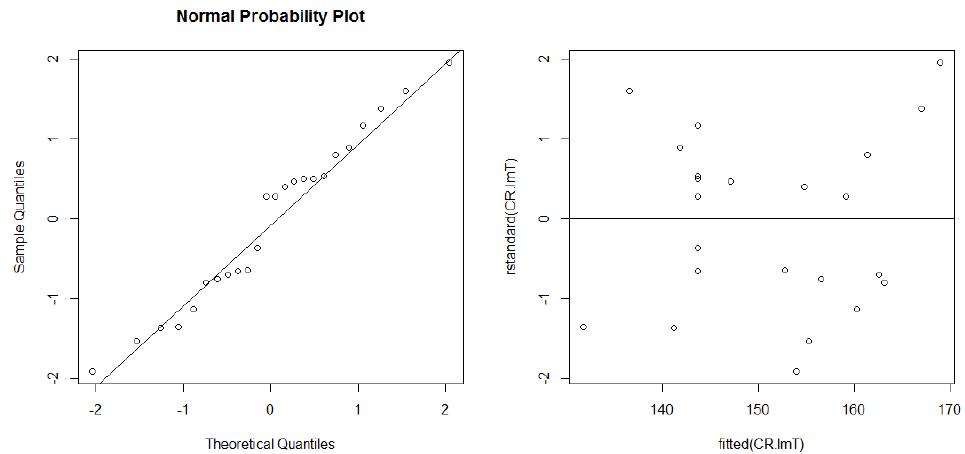
Figure 9. Normal probability plot of residuals, and plot of residuals vs. fitted values, for total thickness data.